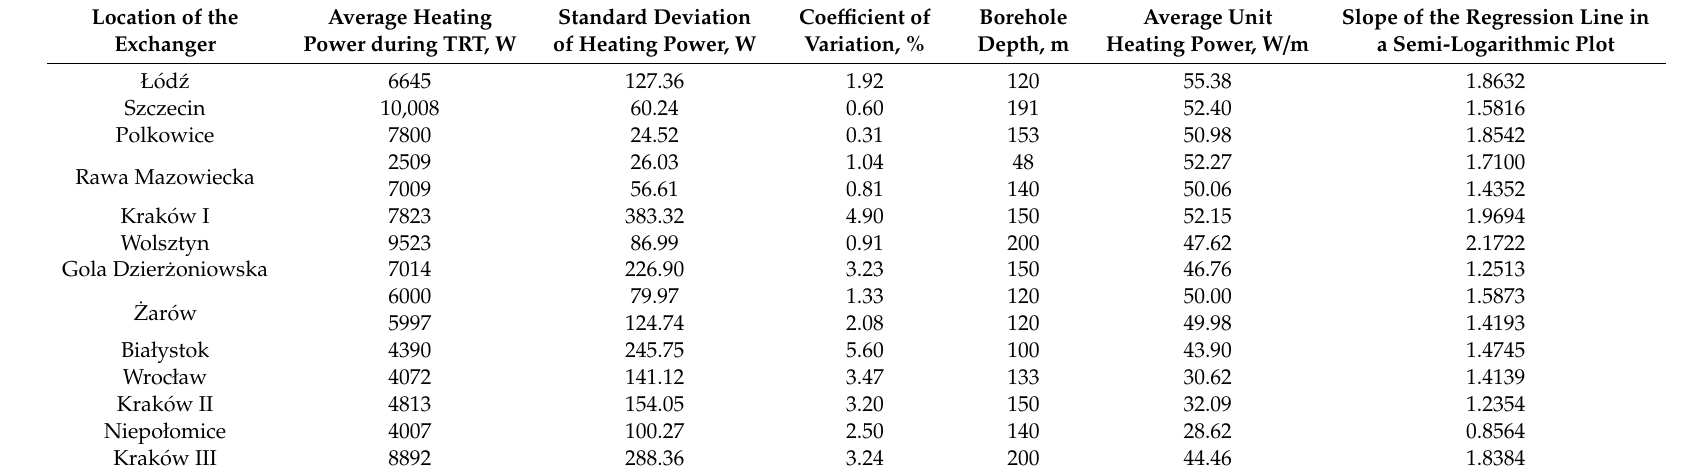
Table 5. Parameters of the tested exchangers, with the interval of every 1 min.